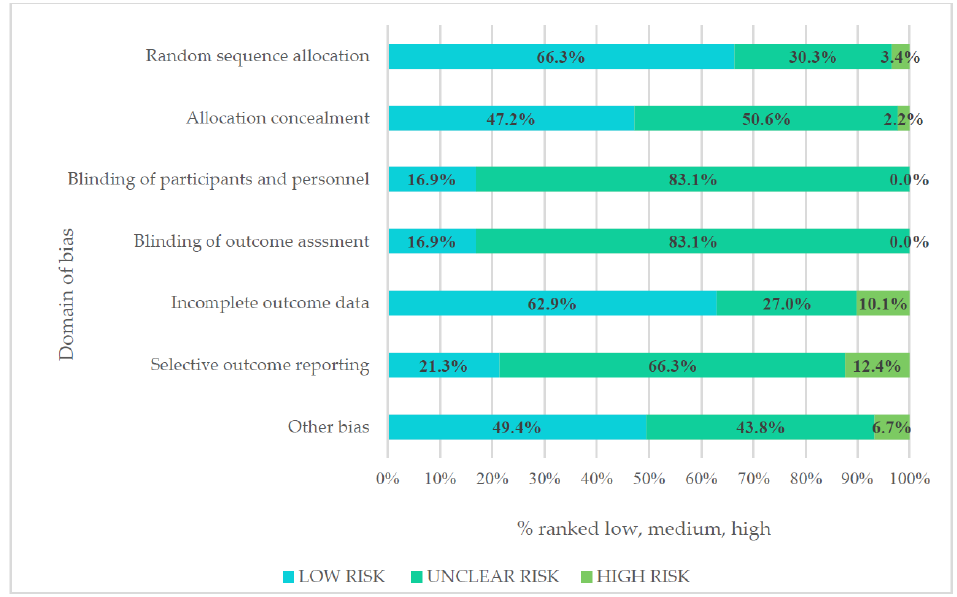
Figure 2. Risk of bias assessed using the Cochrane collaboration tool for assessing risk of bias.